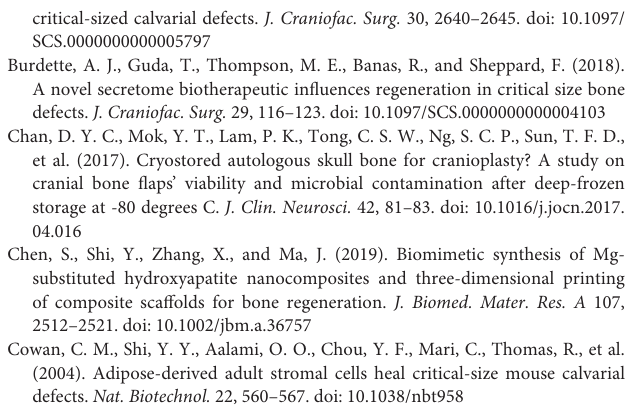
Supplementary Figure 1 | H&E staining of liver and kidney in normal mice, GelMA, Mg-IHC-treated mice. Blank was the sample from a normal female mouse with the same age as in GelMA and Mg-IHC